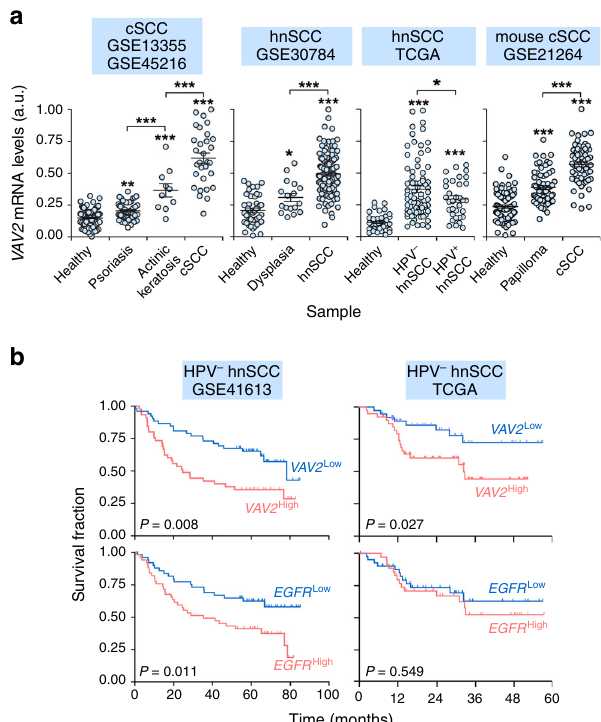
Fig. 1 VAV2 mRNA levels correlate with poor prognosis in HPV – hnSCC. a Expression of VAV2 mRNA in indicated samples (bottom) and gene expression datasets (top). * P = 0.029 (dysplasia versus healthy, hnSCC), 0.047 (HPV − versus HPV + hnSCC); ** P = 0.005 (psoriasis versus healthy, cSCC); *** P < 0.0001 (all other analyses) using ANOVA and Tukey ’ s HSD tests (from left to right, n = 220, 229, 155, and 273 patient samples, respectively). When data were generated using two datasets at the same time, we used frozen robust multiarray analyses (fRMA) to avoid batch effects as indicated in Methods. Data represent the mean ± SEM. b Survival of HPV − hnSCC patients according to the abundance of VAV2 and EGFR mRNAs in tumors in indicated datasets (top). The Mantel – Cox test P value is indicated for each transcript. Source data for this fi gure are provided as a Source Data fi